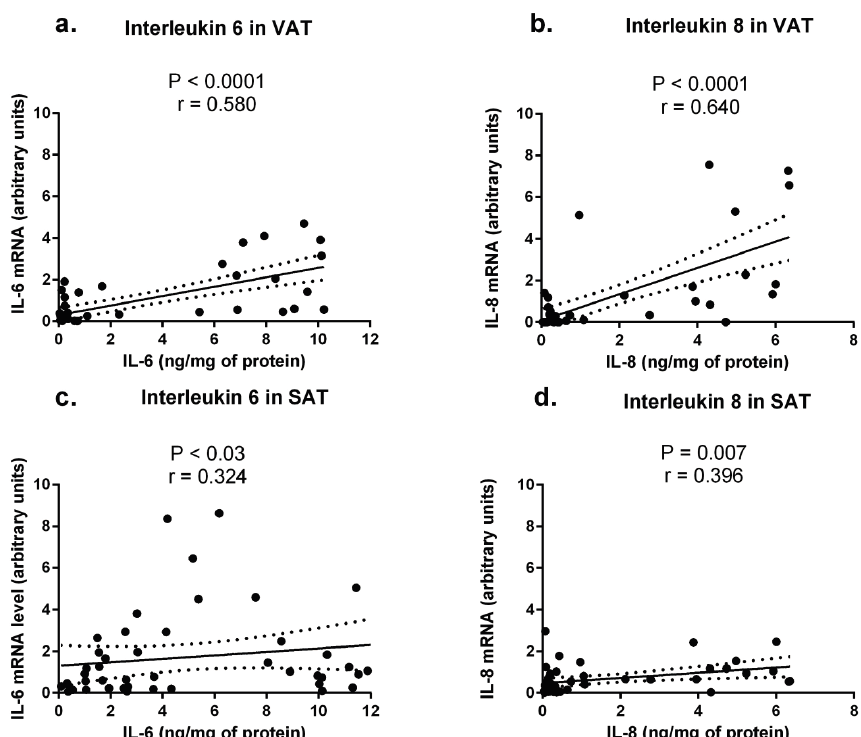
Figure 3. Correlation of interleukin 6 and interleukin 8 protein and mRNA levels in the visceral (VAT) and subcutaneous (SAT) adipose